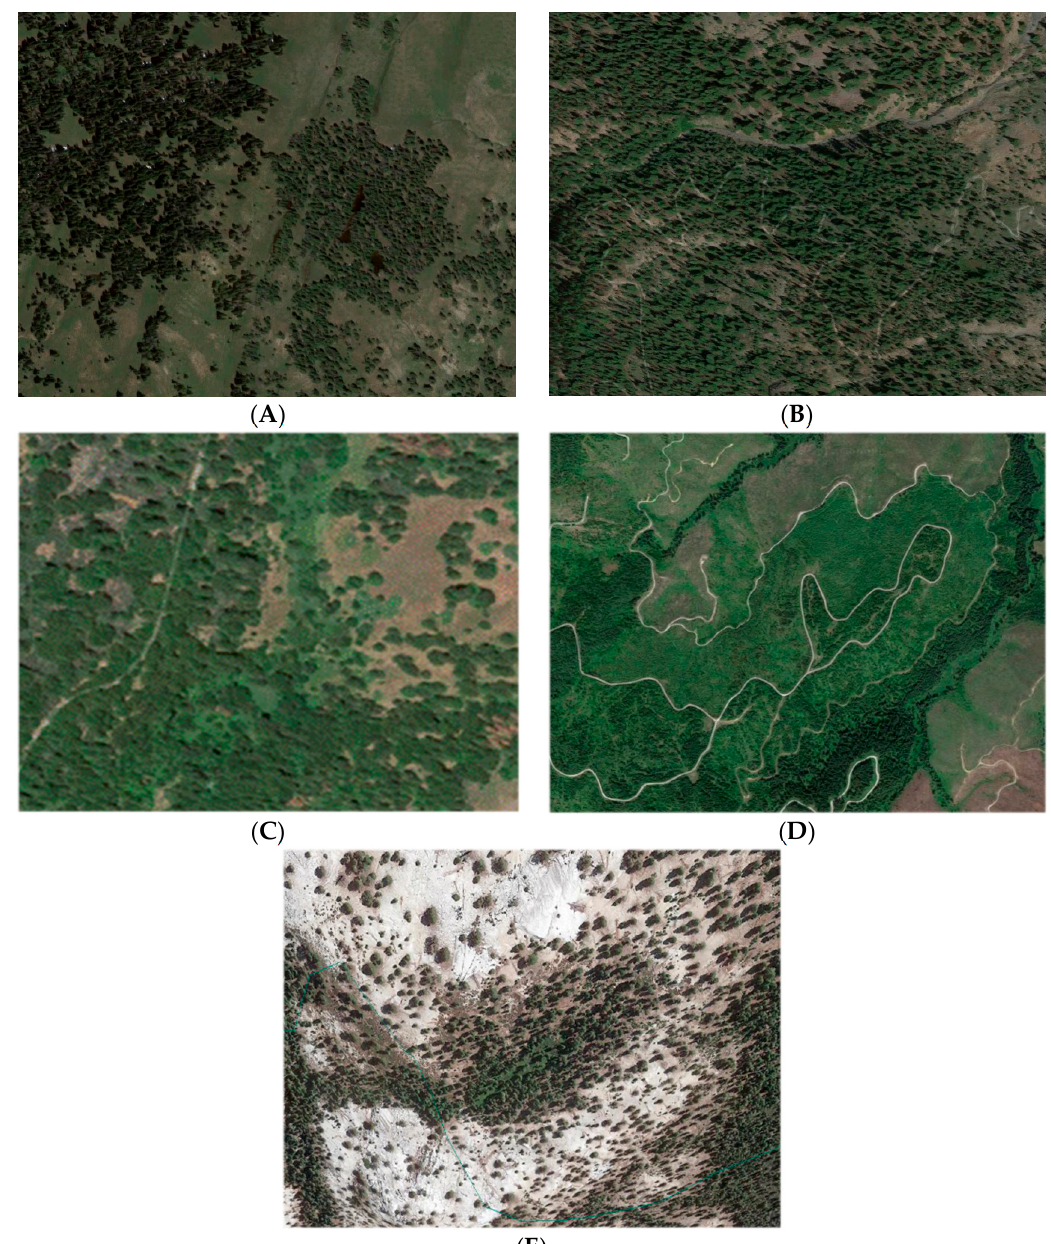
Figure 3. Both brain tumor cells and trees proliferate in a nonadherent semi-sphere shape, whereas neuron cells and forest areas that adhere to the pattern do not proliferate and do not form semi-spheres. Forest trees which display an opposite growth pattern to the identified tree formation in Bridger Teton National Forest ( A ), Okanogan-Wenatchee National Forest ( B ), Eldorado National Forest ( C ), Clearwater National Forest ( D ), and Rio Grande National Forest ( E ).